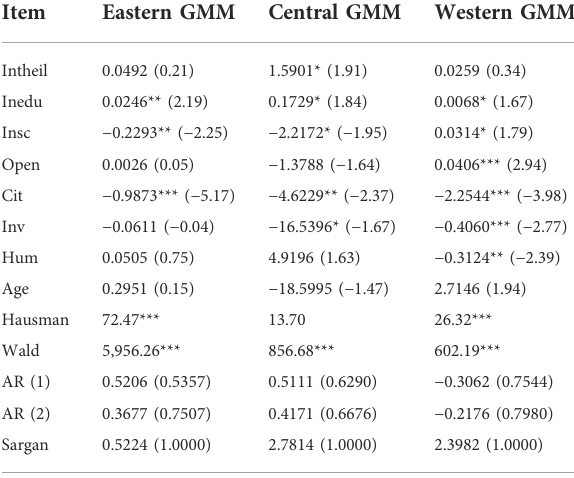
TABLE 4 Empirical results among educational investment, social security expenditure, and the income gap between urban and rural